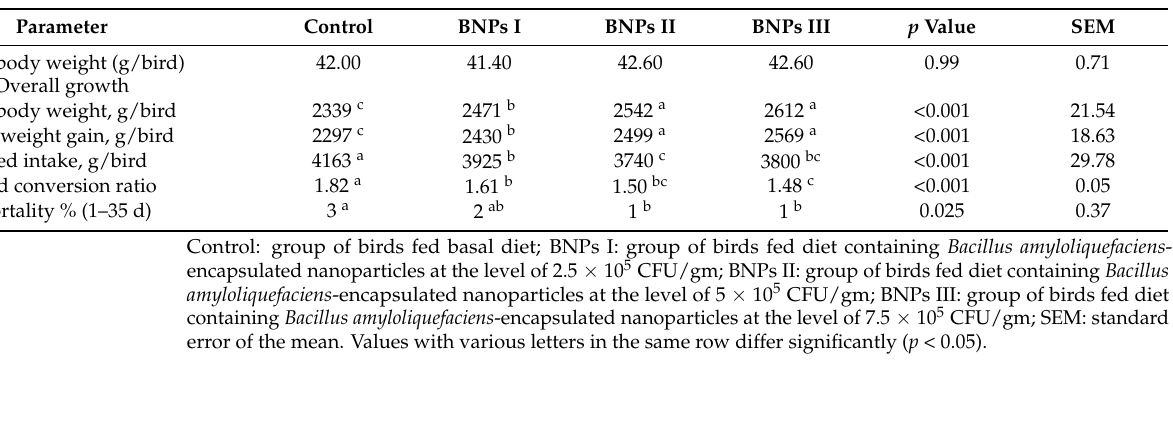
Table 3. Effect of feeding male Ross broilers a diet formulated with three different levels of